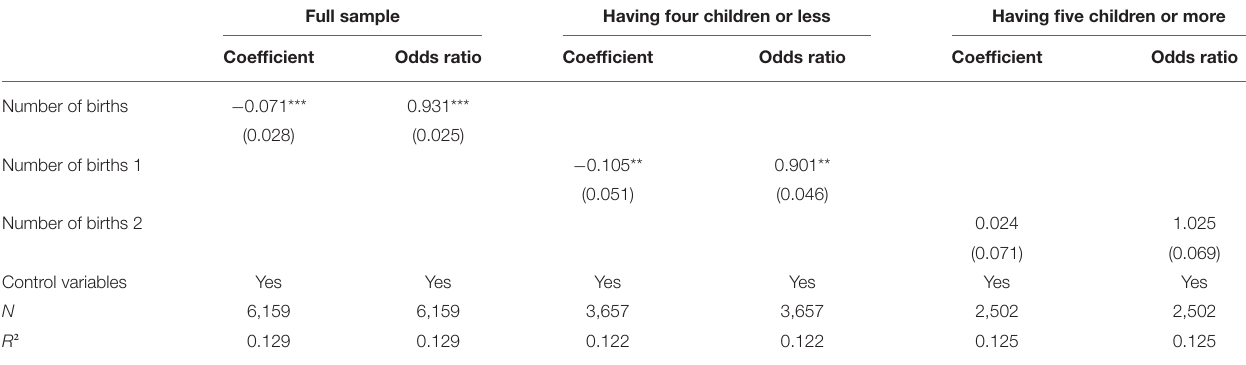
TABLE 3 | Subgroup analysis.